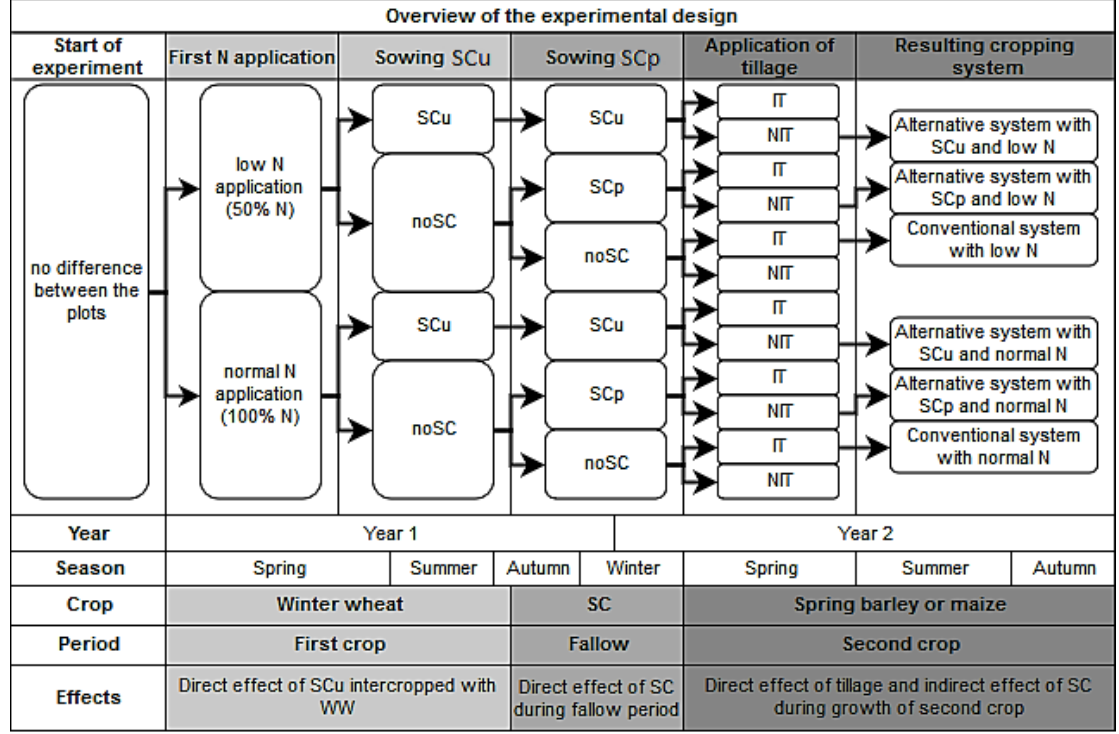
Figure 1. Graphical overview of the experimental treatments and experimental periods. The trial was repeated over two periods (2012–2014 and 2013–2015). The design is also applicable to the sites with no fertilization factor. (SCu—subsidiary crops under-sown with first crop, SCp—subsidiary crops were sown post-harvest of the first crop, noSC—no subsidiary crop establishment, IT—inversion tillage, NIT—non-inversion tillage, WW—winter wheat, N—nitrogen, SC—subsidiary crops).